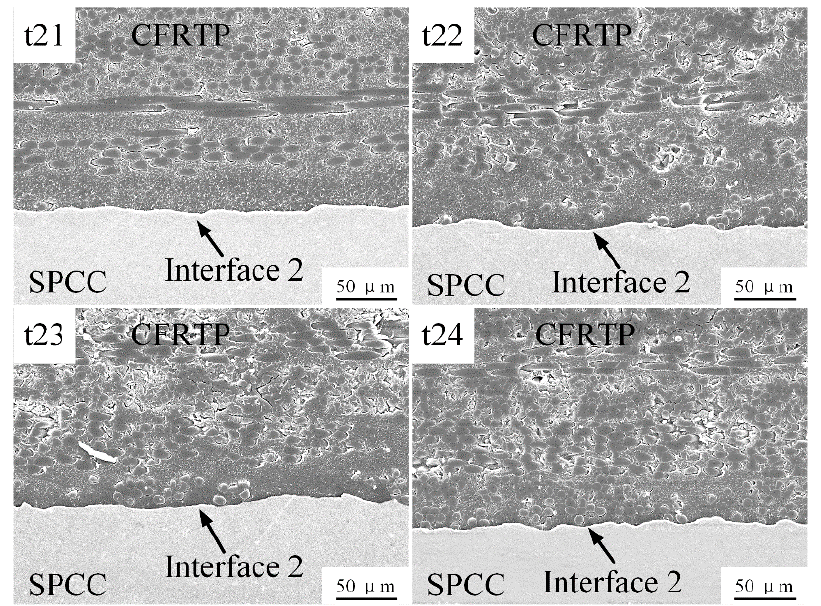
Figure 21. Microstructures of interface 2 obtained under 240 °C.